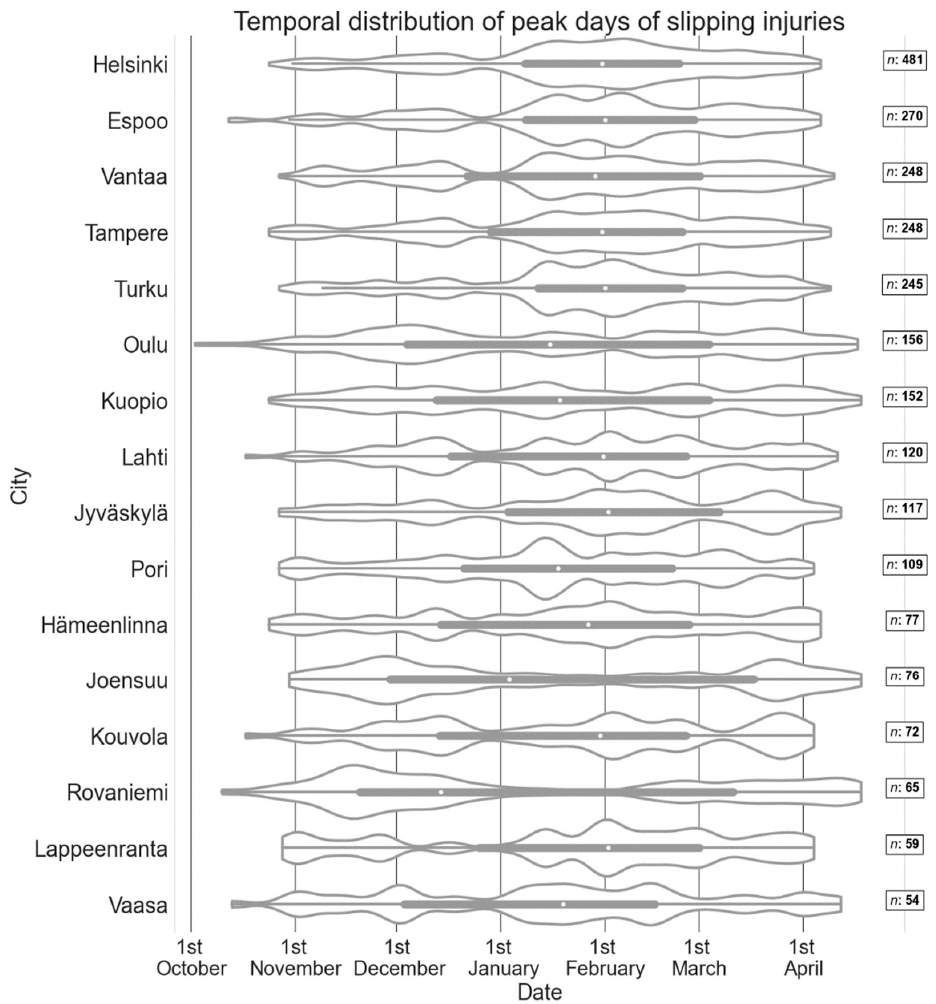
Figure 3. The temporal frequency distribution of peak days of slipping injuries in different cities in winters 2005–2019 presented on a violin plot. The width of the span corresponds to the frequency of slip injuries, the wider the distribution is the more slip injuries happen. The white dot within each box represents the median dates of the winter season slips. The box spans the 0.25 and 0.75 quantiles, and the whiskers represent the minimum and the maximum dates. Outliers are within the violin plot area. The number of peak days ( n ) is presented for each city on the right.